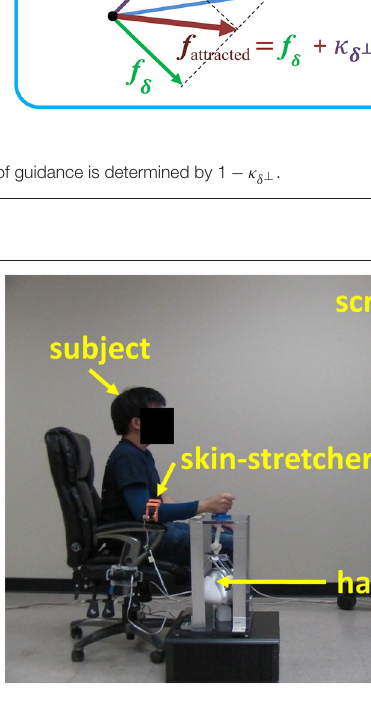
FIGURE 8 | A subject is driving a virtual power-wheelchair during the experiment.